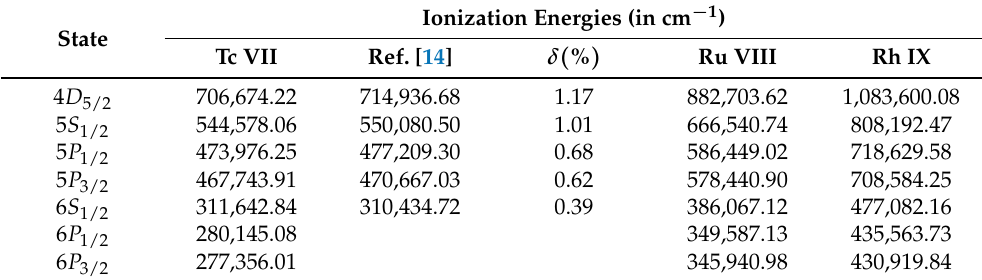
Table 1. Ionization energies (cm − 1 ) for few, low lying and excited states using RMBPT method for Tc VII, Ru VIII and Rh IX, compared with RCC ionization energies provided by Das et al. [14]. The ground state ionization limit is taken from NIST AD [25].